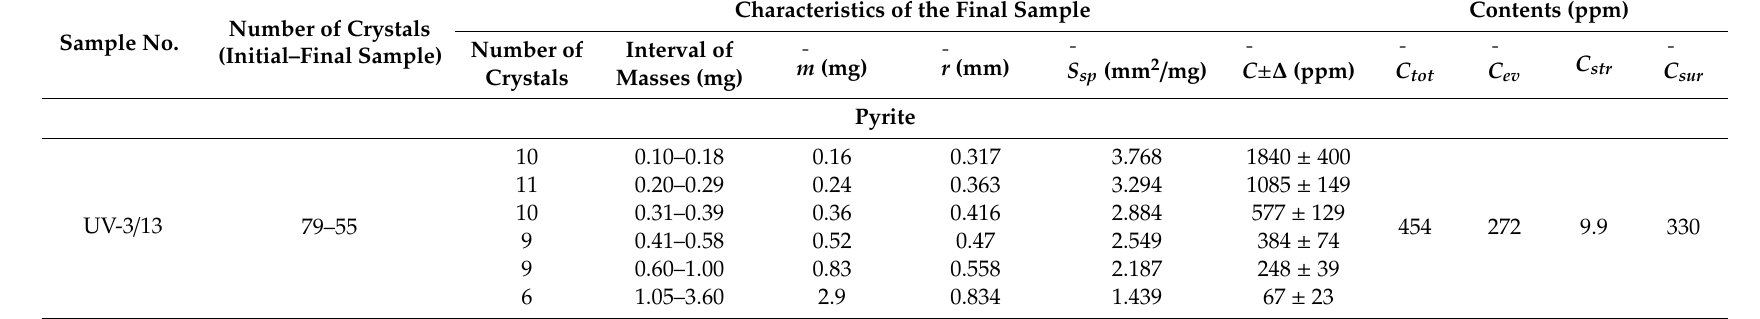
Table 6. Results of rhodium analysis of size selections of arsenopyrite single crystals from vein and streaky-vein ores of the Natalkinskoe deposit.